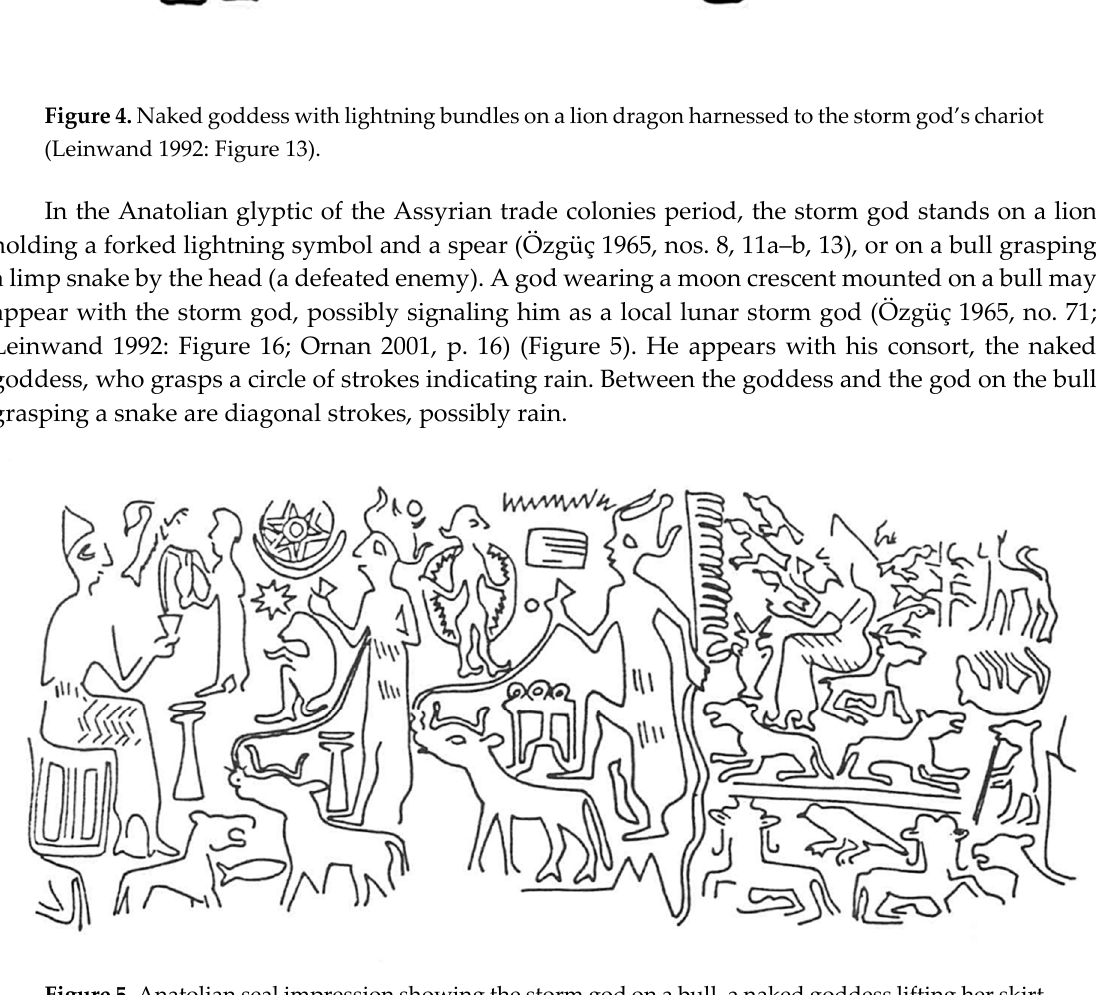
Figure 5. Anatolian seal impression showing the storm god on a bull, a naked goddess lifting her skirt and rain (Leinwand 1992: Figure